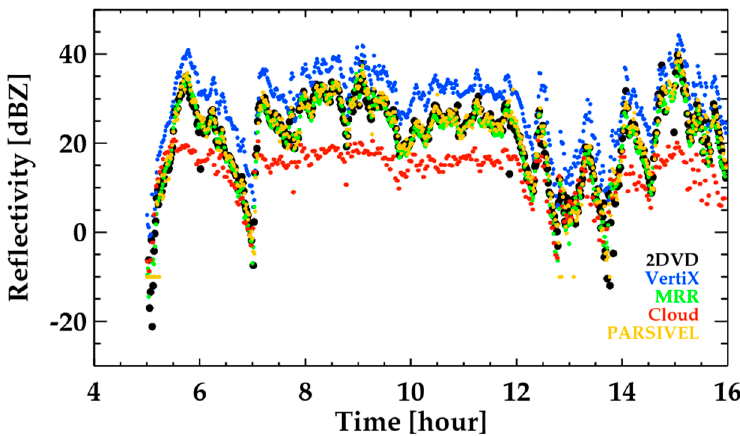
Figure 5. Time series of radar reflectivity from five instruments (black: 2DVD; yellow: PARSIVEL; blue: VertiX at 472 m height; green: MRR at 400 m height; red: cloud radar at 400 m height) from 0400 to 1600 UTC, 2 July, 2014 (case 4 in Table 2).